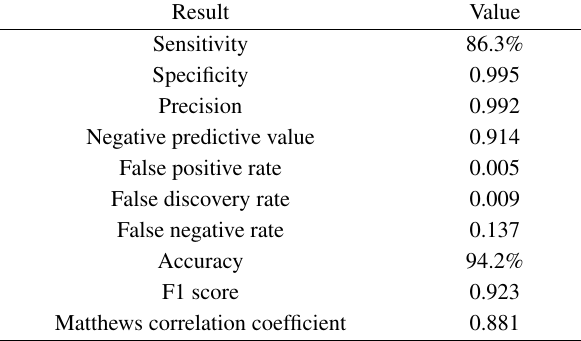
Fig. 7 Confusion matrix of the proposed model. Table 2 Testing results obtained through the proposed